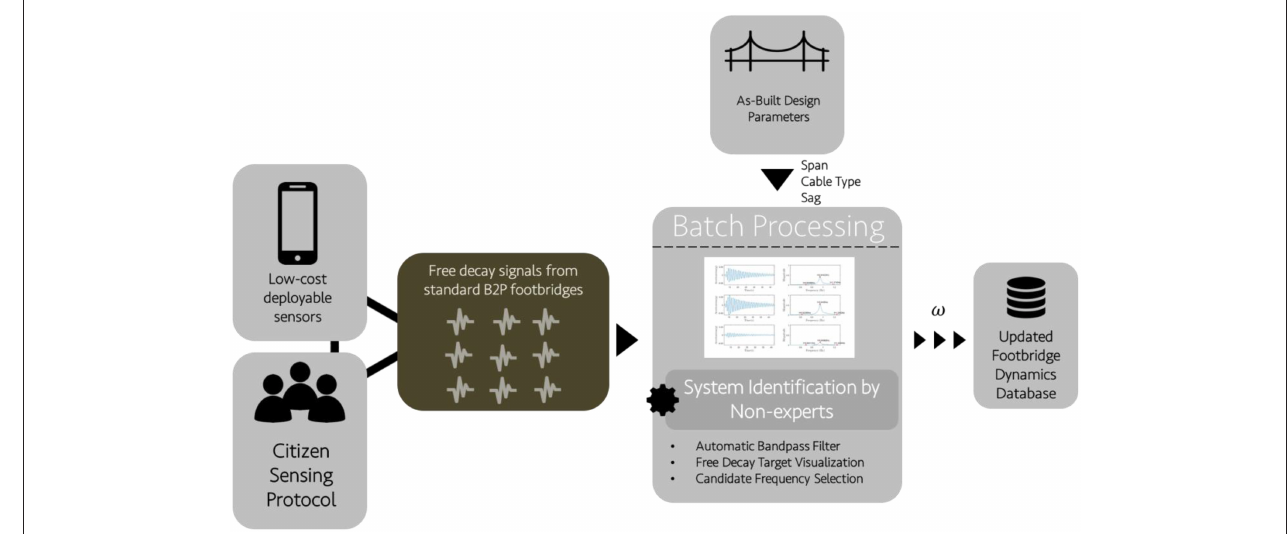
FIGURE 17 | A schematic diagram of batch processing of citizen sensing data.